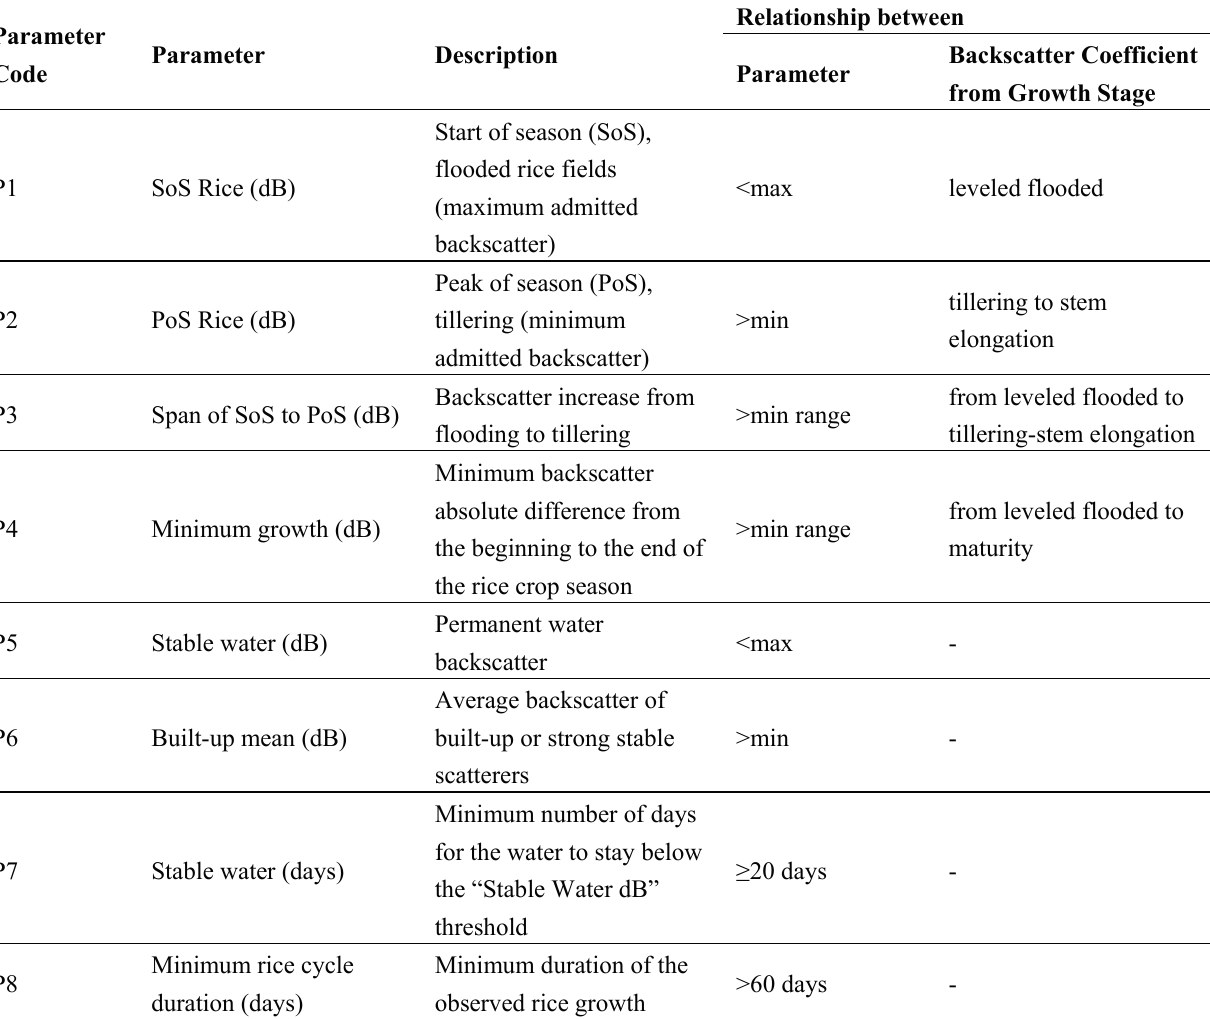
Table 4. Threshold parameters for rice identification and detection of flooding/transplanting